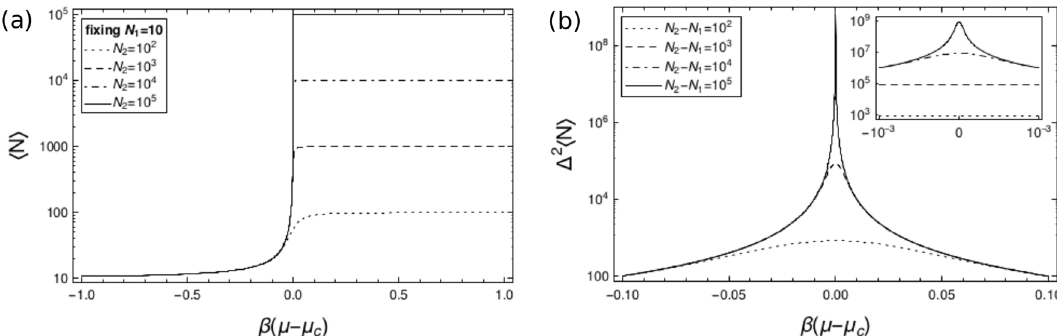
Figure 2. Semi-log plot of the average number of particles (cid:31) N (cid:30) (setting N 1 = 10 ) and of the particle number 2 N fluctuations (cid:31) as a function of the rescaled chemical potential β(µ − µ c )